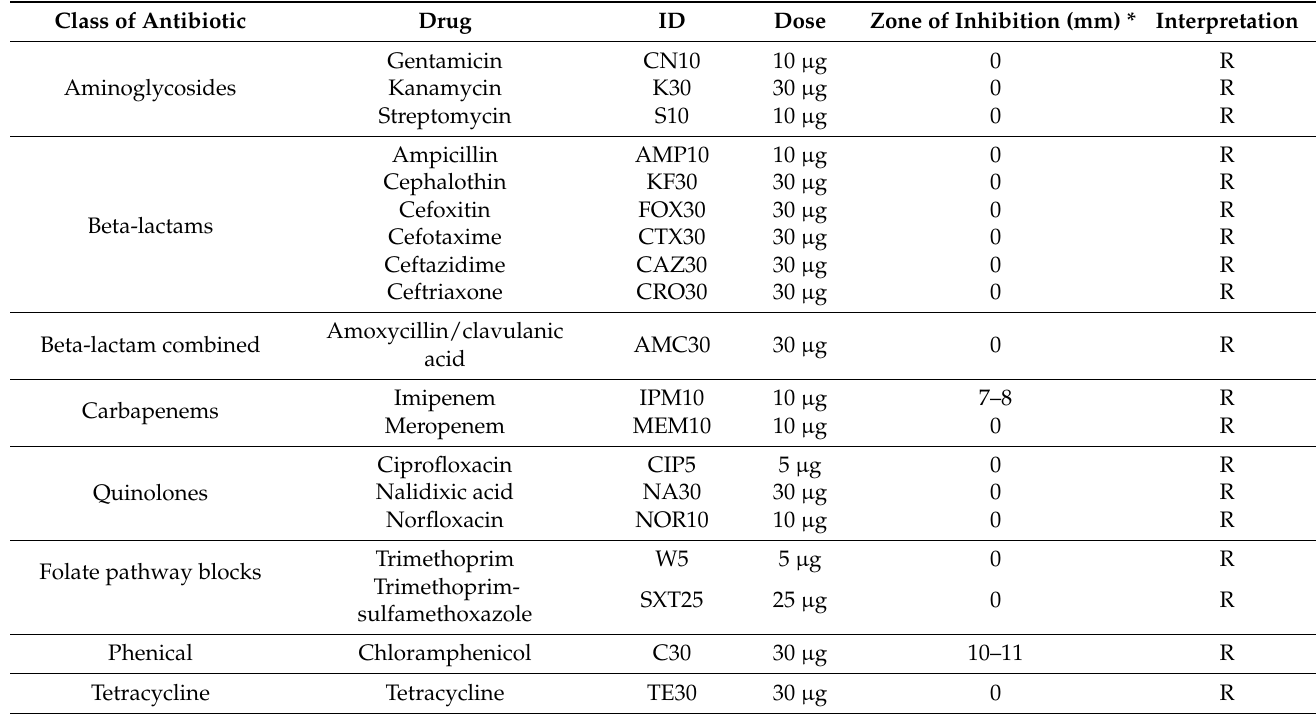
Table 1. Antibiotic susceptibility profiling of A. baumannii Aci46 by disk diffusion method.